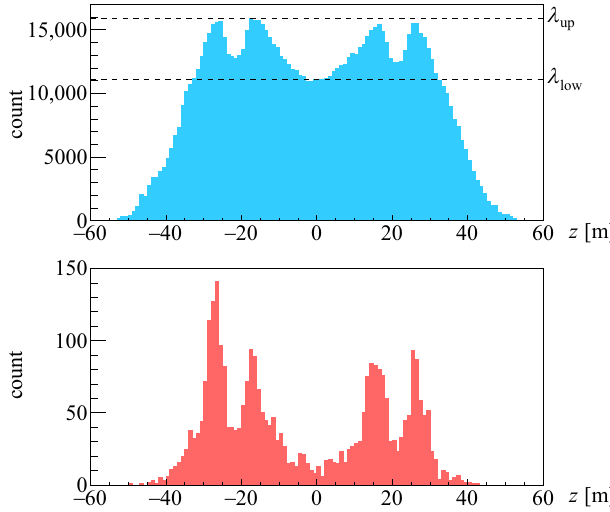
FIG. 2. Simulated longitudinal distribution of the beam (upper) and beam loss (lower). The beam distribution in the upper panel was captured at 24,100 turns (130 ms) from the beam injection. The lower image shows the particles lost between the 500th and the 24,100th turns.